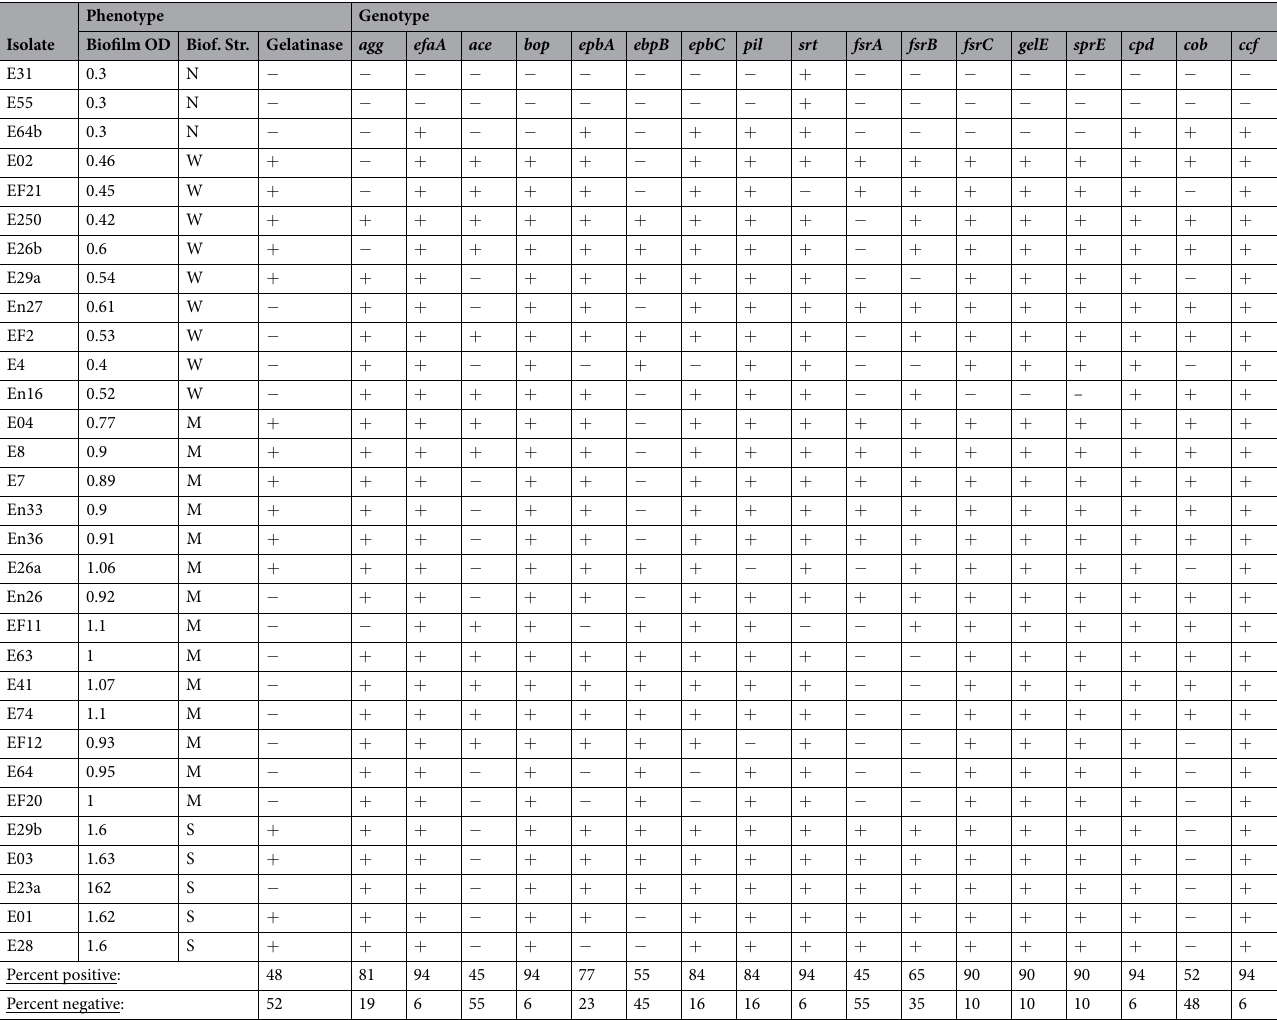
Table 3. PCR screening results. Key: + , positive; − , negative; Biofilm formation strength (N, none; W, weak; M moderate, S, strong; Biof. Str. = Strength of